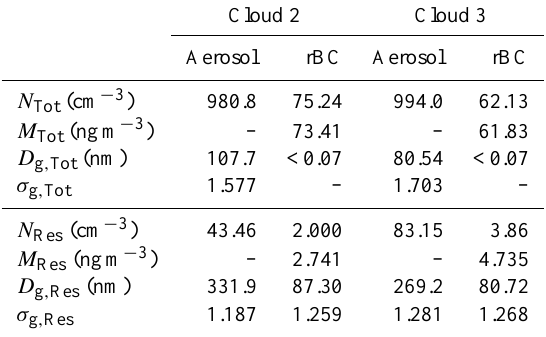
Table 2. Averaged number ( N ) and mass ( M ) concentrations and modal parameters D g and σ g for aerosol and rBC particles during the two cloud events measured at Mt. Soledad. The subscripts Tot and Res represent measurements made from the total and residual inlets,